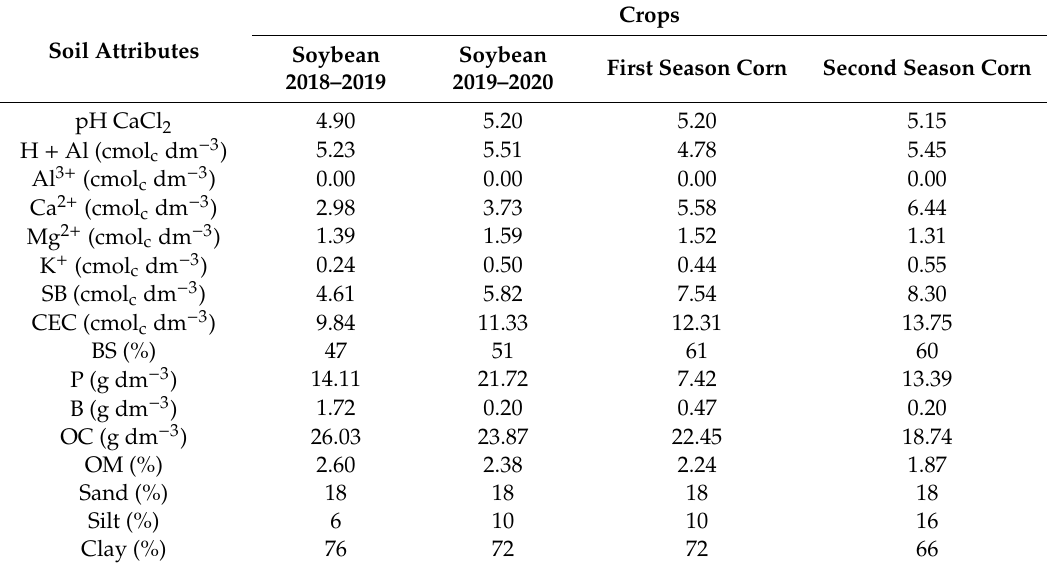
Table 1. Chemical and physical characterization of the dystrophic Red Latosol (Hapludox) at a depth of 0–20 cm from soybean and corn